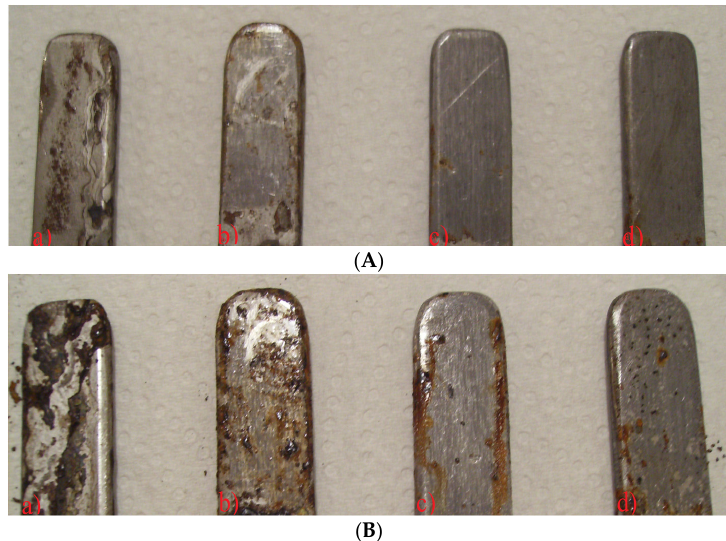
Figure 6. Weight loss results from salt spray experiments for bare steel and steel coated with pristine epoxy resin, and nanocomposites with I.28 and I.30 organo ‐ clays, after 1 day ( a ) and 4 days ( b ) of exposure in a corrosive environment of 100% saturated moisture + 5 wt % NaCl solution.